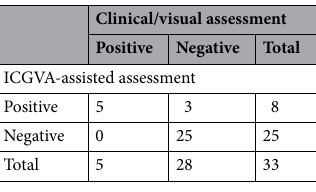
Table 1. Cross table for ICGVA-assisted thrombus detection.